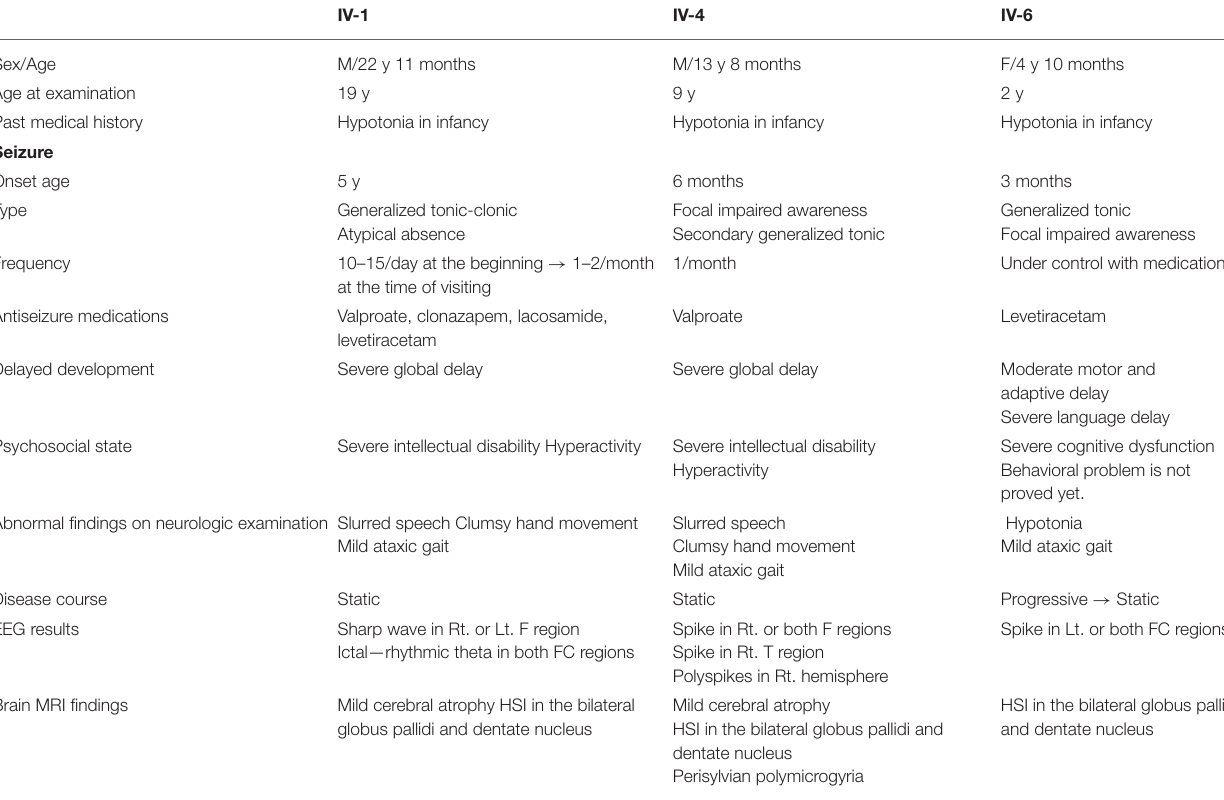
TABLE 2 | Clinical characteristics of three affected